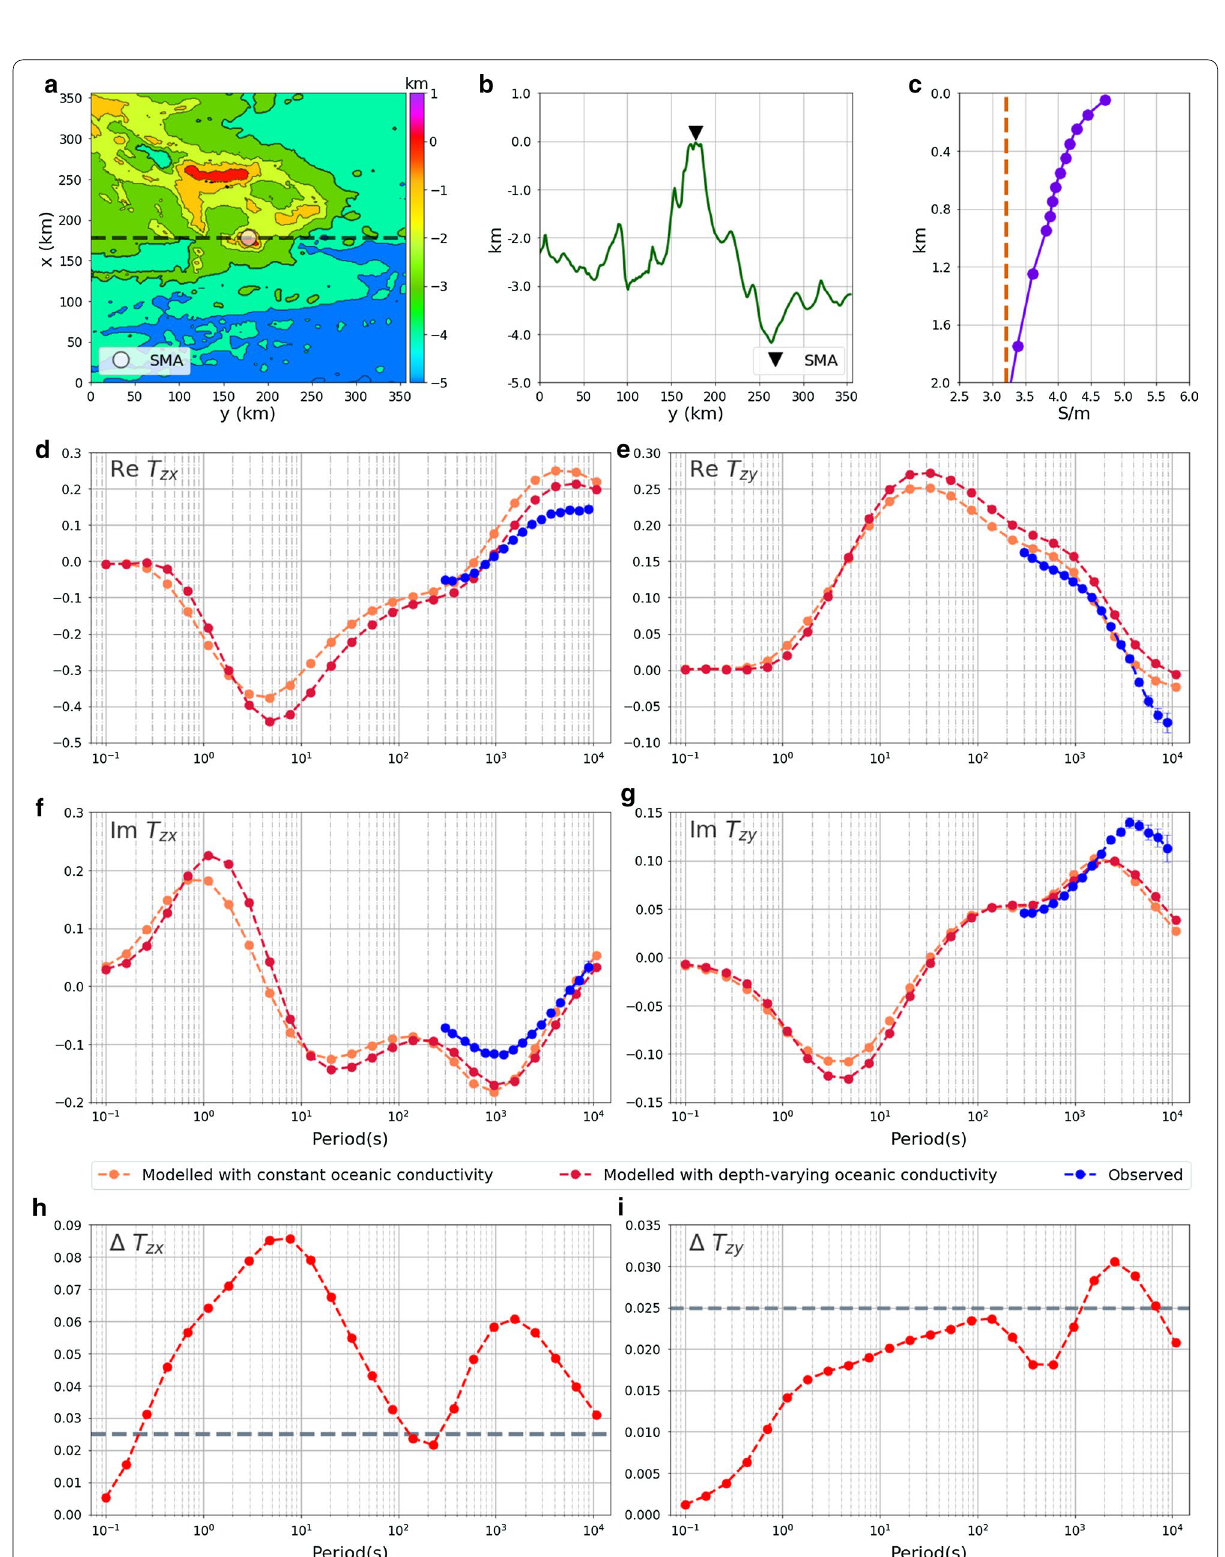
Fig. 14 Same as Fig. 5, but for Santa-Maria/Azores observatory